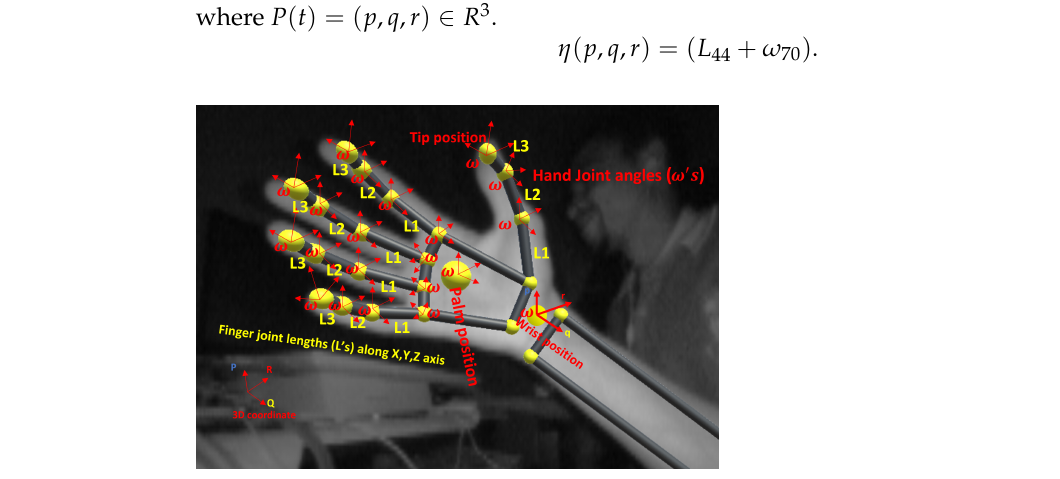
Figure 2. Skeletal palm joints with angle and joint length primes captured by LMC